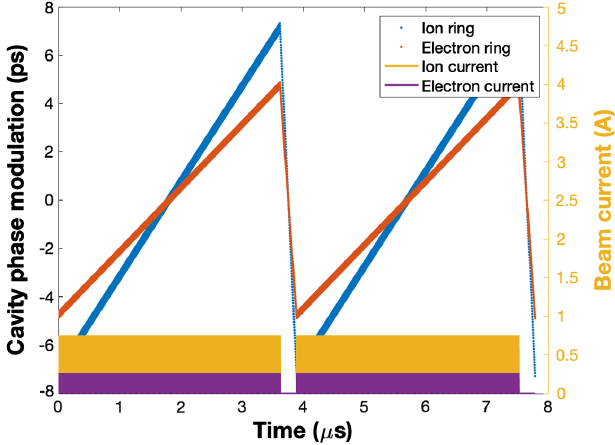
FIG. 16. Optimal phase modulation for both rings.